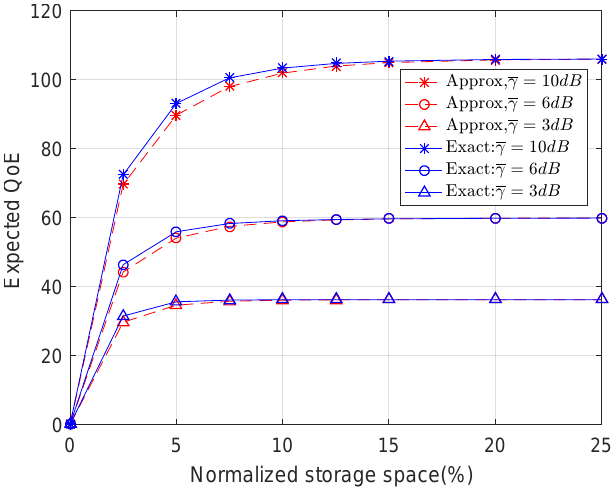
Figure 8. The expected QoE as a function of the normalized storage space with approximated and exact utility functions.